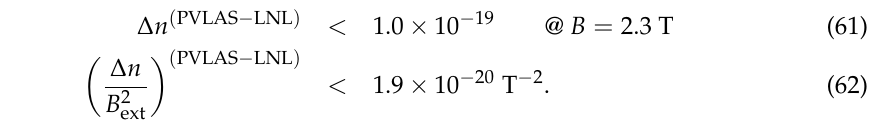
of VMB at 95% c.l.